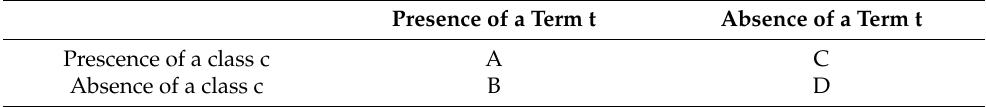
Table 3. Association between t and